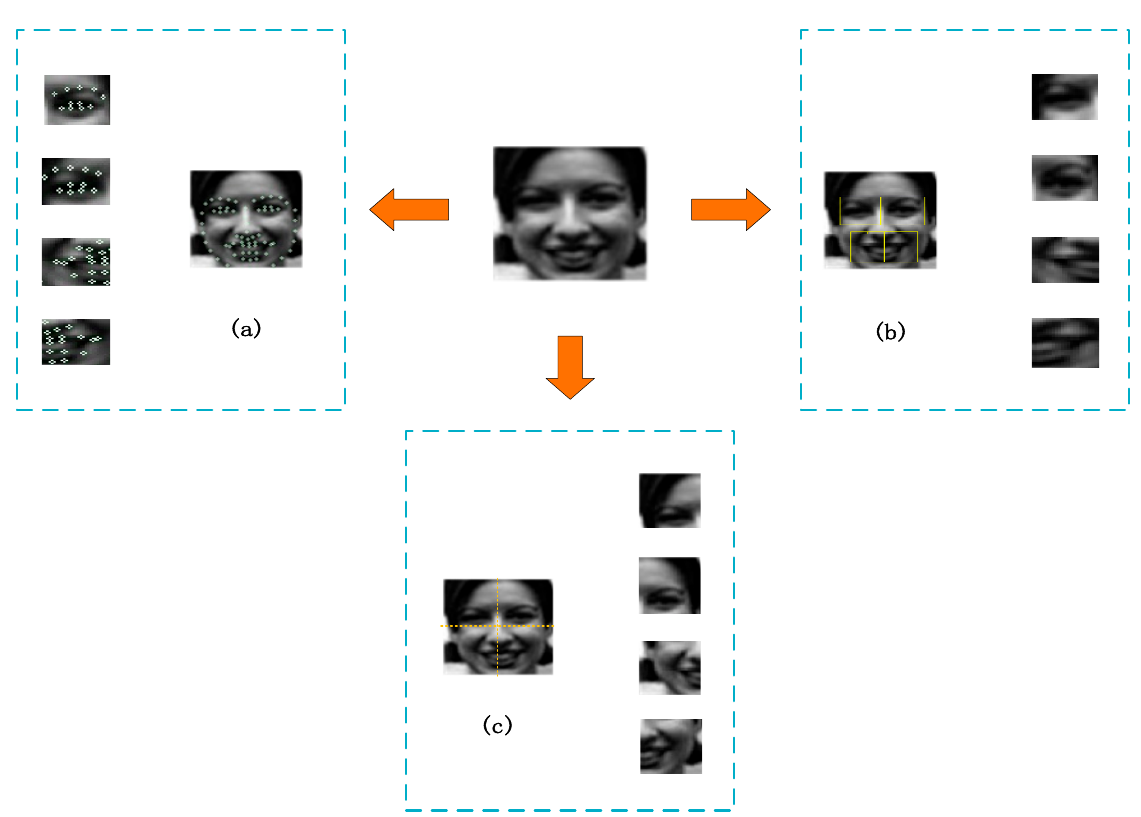
Figure 4. Example of facial key region segmentation method. ( a ) The 42-point cropping method based on face; ( b ) Crop method based on four regions of the face; ( c ) Four-equivalent cropping method based on face image.